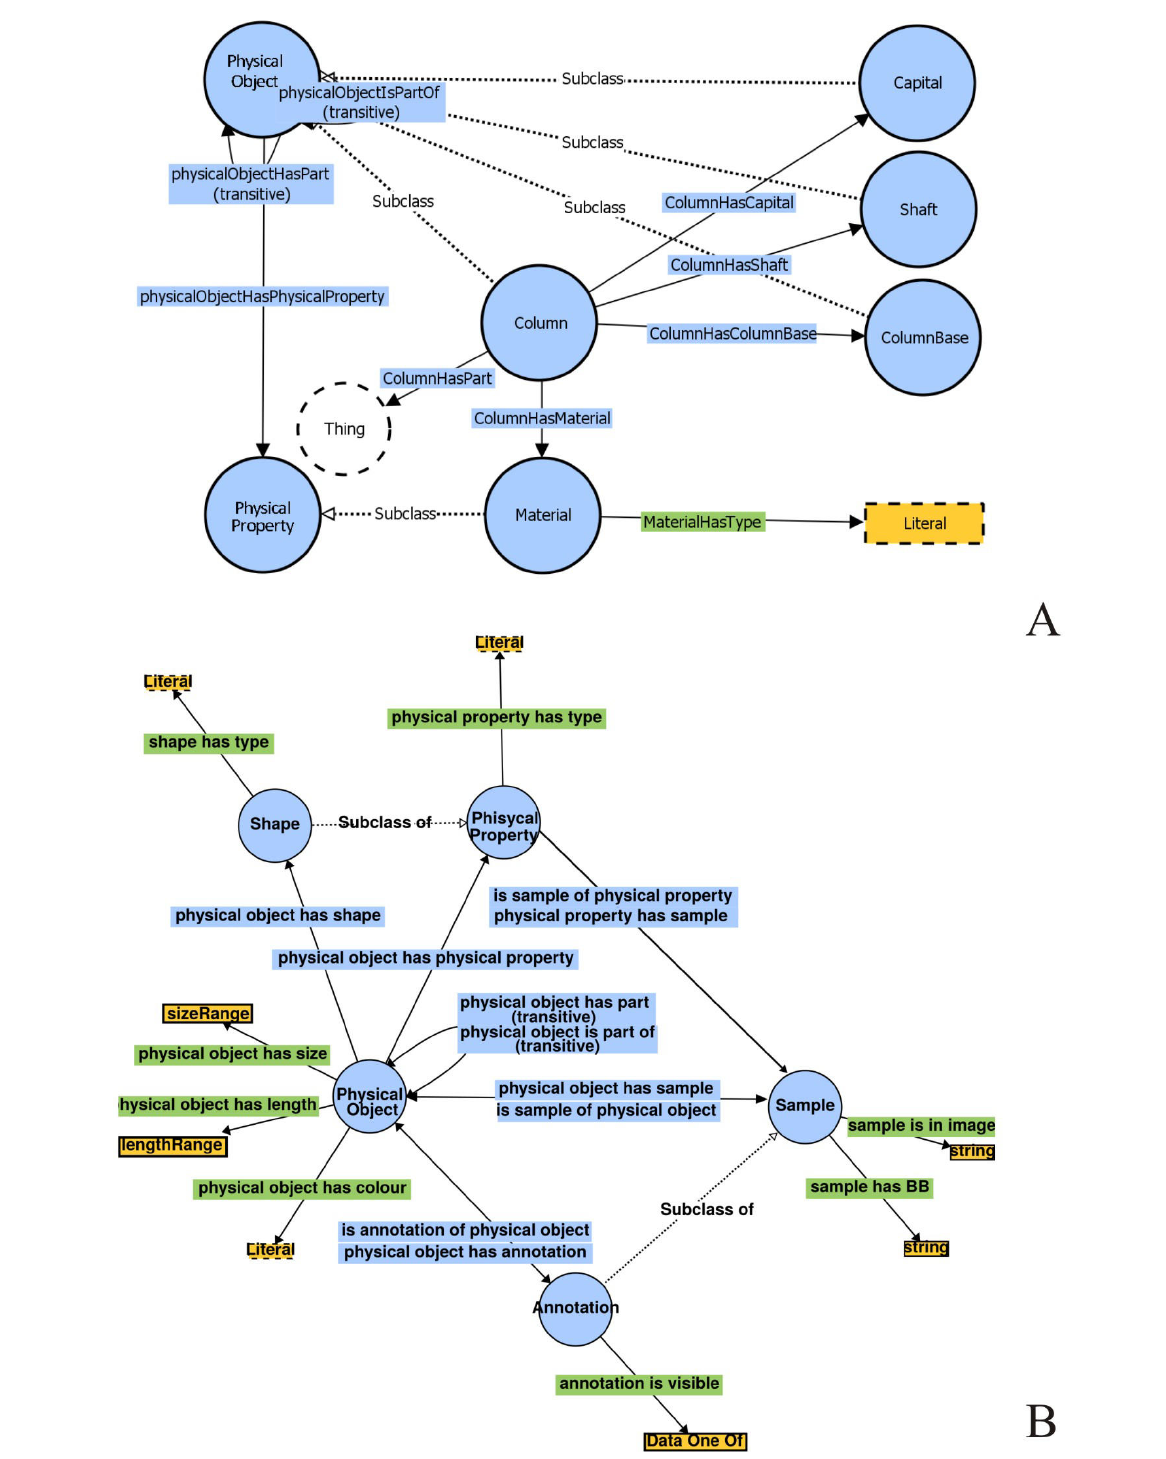
Figure 1. (A) The Visual OWL representation of a subsection of the developed ontology. In particular, Column , Capital , Shaft and ColumnBas e are defined as subclasses of PhysicalObject and are linked to each other by relationships in the form of XHasY ; the column material is in turn defined as a subclass of PhysicalProperty . ( B). Extension of our visual ontology to support the annotation